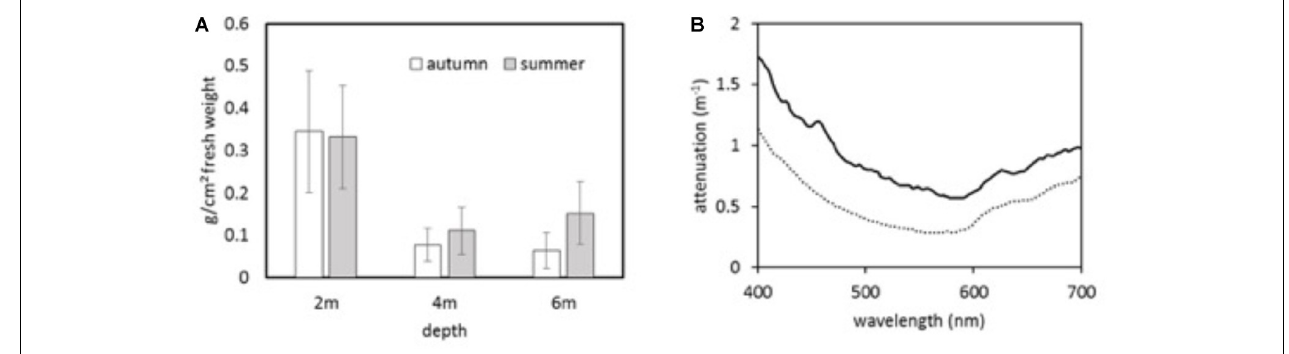
FIGURE 13 | (A) Total fresh weight of macrophytobenthos along a transect in front of the Hütelmoor in autumn and summer 2016. For each depth, six replicates were sampled by means of Scuba-diving; (B) Attenuation spectra recorded in July (solid line) and October (dotted line) close to the transect position. Lower attenuation in autumn is overcompensated by lower solar